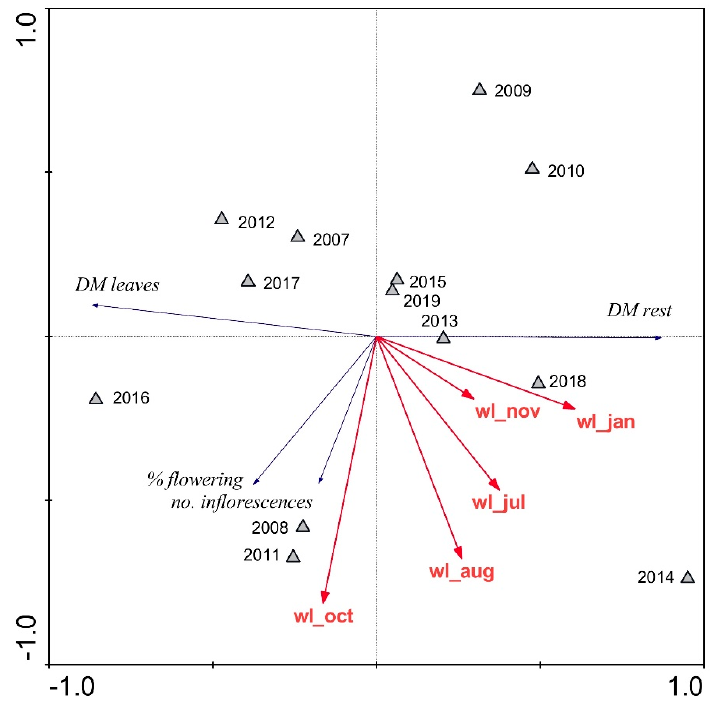
Figure 7. Redundancy analysis plot showing the strengths of the associations between monthly water levels and assimilate allocation parameters of the common reed from the riparian stand (Gorenje Jezero). Triangles: different years; DM: dry mass; wl: water level; no.: number.